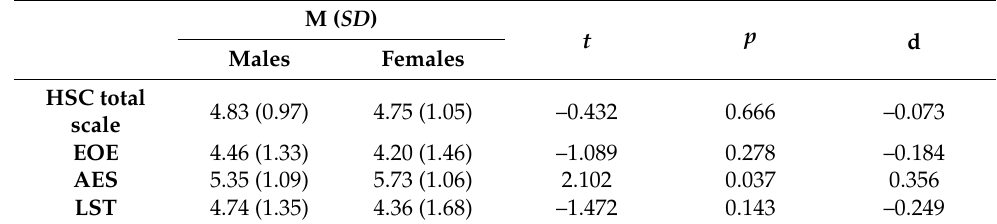
Table 6. Differences between males and females regarding the environmental sensitivity in children.